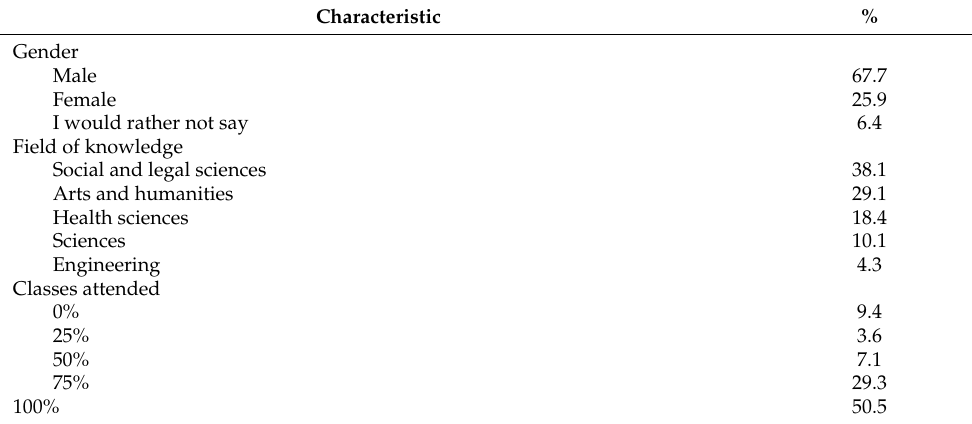
Table 2. Characteristics of the